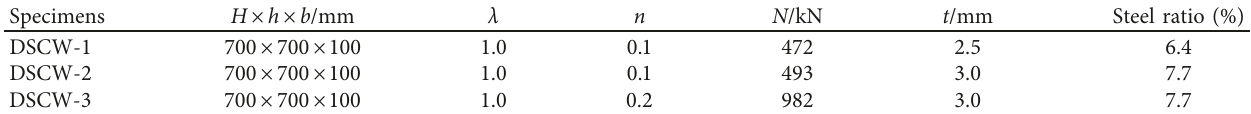
Figure 1: Geometries of DSC composite walls (dimensions in mm). Table 1: Parameters of test